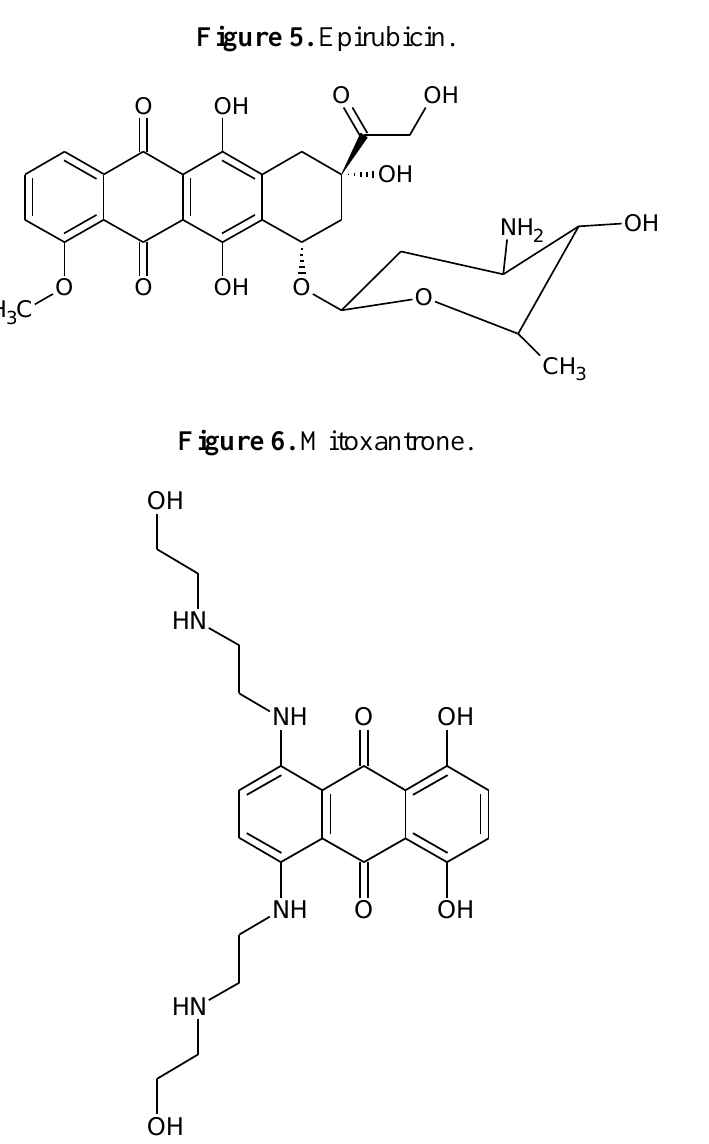
Figure 5. Epirubicin.